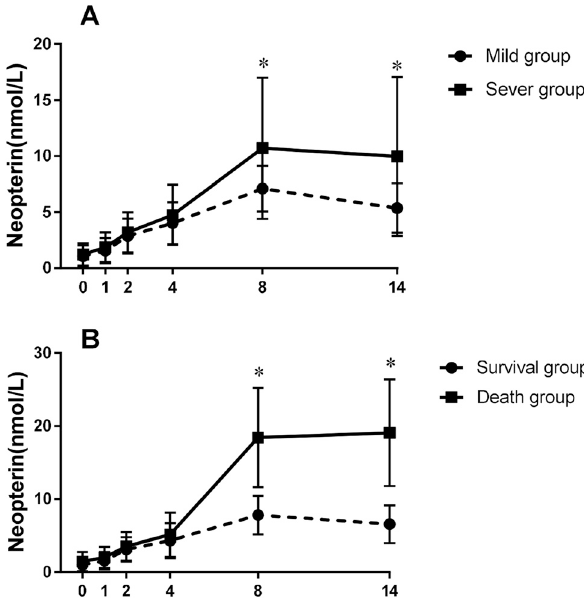
Figure 2: Serological neopterin dynamitic changes from day 0 to day 14 in different